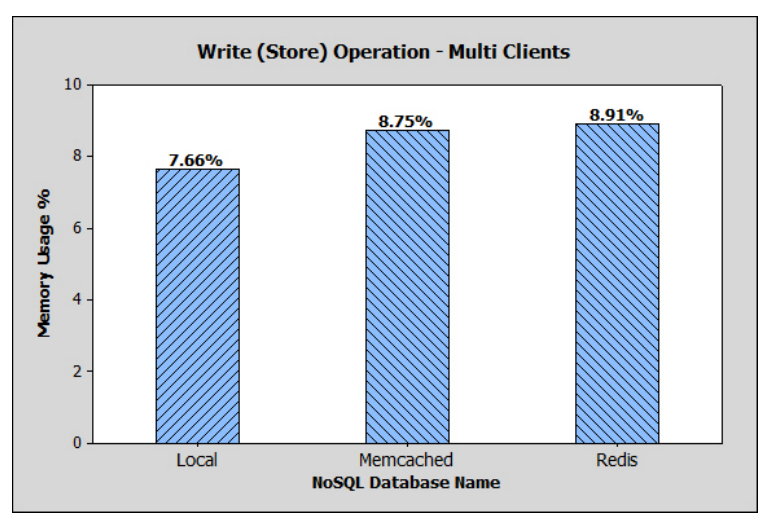
Figure 9. Memory usage with write operation (multi